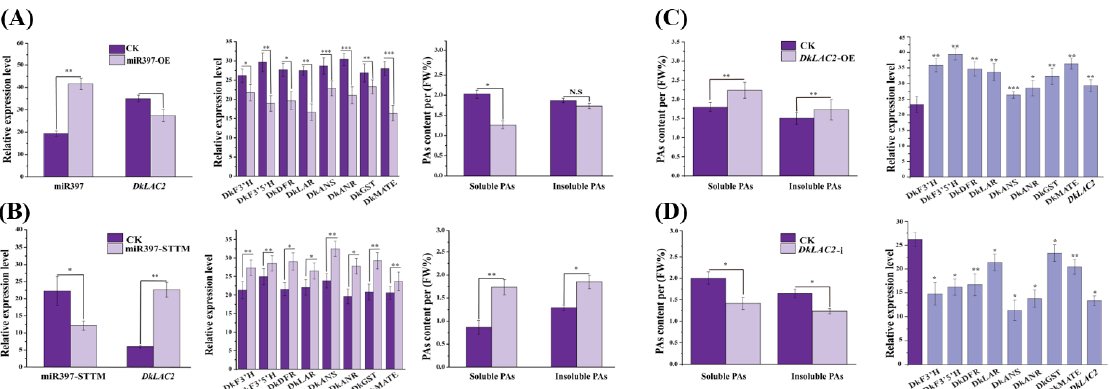
Figure 3. Transient expression of DkmiR397 and DkLAC2 in ‘Eshi 1’ (C-PCNA) persimmon leaves in vivo. ( A ) Evaluation of DkmiR397, DkLAC2 , and PA biosynthesis pathway gene transcript levels, as well as the related fluctuation in PA content, after transient overexpression of pre-miR397 at ten days after agroinfiltration. ( B ) Evaluation of DkmiR397, DkLAC2 , and PA biosynthesis pathway gene transcript levels, and the related fluctuation in PA content, after transient of STTM397 at ten days after agroinfiltration. ( C ) Evaluation of DkLAC2 -OE, and PA biosynthesis pathway gene transcript levels, and the related fluctuation in PA content, after transient overexpression of DkLAC2 at ten days after agroinfiltration ( D ) Evaluation of DkLAC2 -i, and PA biosynthesis pathway gene transcript levels, and the related fluctuation in PA content, after transient silencing of DkLAC2 -i at ten days after agroinfiltration. F 3′ H: flavonoid 3′ -hydroxylase; F 3′5′ H: flavonoid 3′5′ -hydroxylase; DFR: dihydroflavonol 4-reductase; ANS: anthocyanidin synthase; ANR: anthocyanidin reductase; LAR: leucoanthocyanidin reductase; GST: glutathione S -transferase; MATE: multi-drug and toxic compound extrusion transporter. Errors bars indicate SEs from three biological replicates ( n = 3). Asterisks above the bars indicate values determined by Student’s t -test to be significantly different from the control (* p < 0.05, ** p < 0.01, *** p < 0.001).